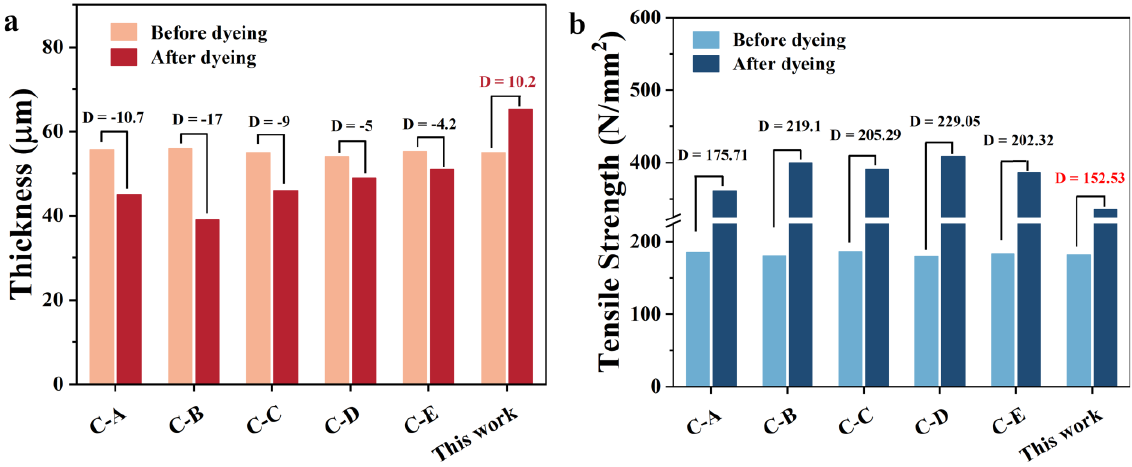
Figure 6. Comparing ( a ) thicknesses and ( b ) tensile strengths of dyed hair using commercial products and gallic-acid-based dye reagents.